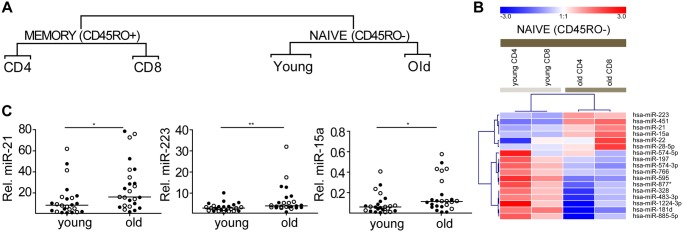
Age-related differences in miRNA expression are predominantly found in CD45RO- T cells.
(A) Unsupervised hierarchical cluster analysis of 166 miRNAs revealed a clear distinction between CD45RO- and CD45RO+ T cells. Within the CD45RO- subgroup the next separation was based on age, whereas in CD45RO+ T cells the next clustering was based on expression of CD4/CD8 (the complete heatmap can be seen in Figure C in S1 File). (B) Heatmap of miRNAs differentially expressed in young versus old CD45RO- T cells (n = 17) using a 2-fold expression change cut-off (≥ 2 fold) between young and old CD45RO- T cells. The blue to red gradient on the heatmap indicates relative miRNA expression levels varying from low (blue) to high (red). (C) Relative expression levels in CD45RO- T cells as determined by qRT-PCR of miR-21, miR-223 and miR-15a in CD45RO- T cells from young and old donors. MiRNA expression levels were normalized to the expression levels of RNU49 (lines indicates median). Filled circles indicate CD4 T cells and open circles indicate CD8 T cells, *p ≤ 0.05, **p ≤ 0.01.